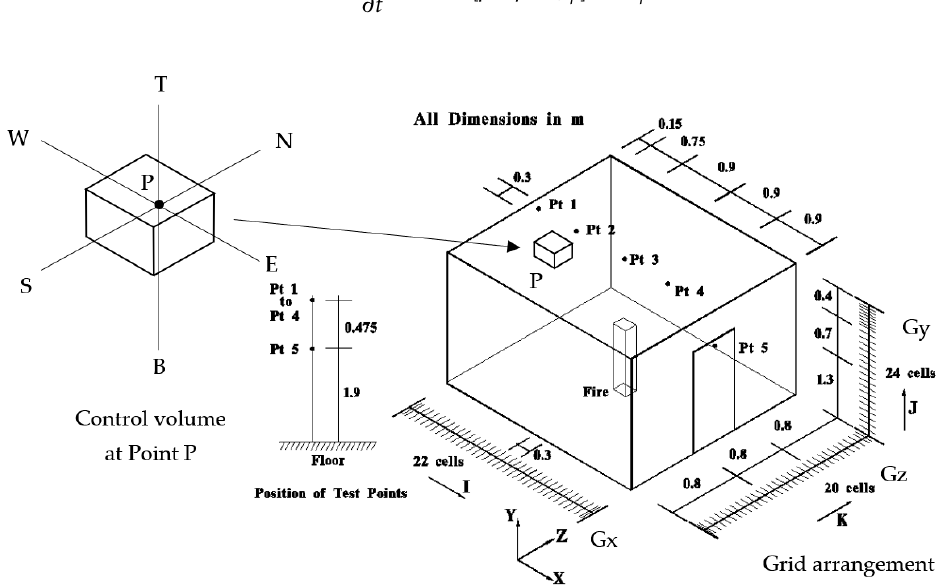
Figure 1. Con fi guration of the test chamber. Figure 1. Configuration of the test